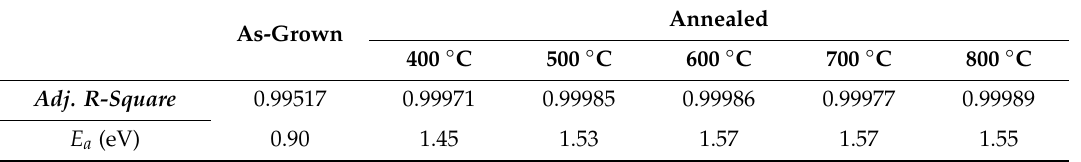
Table 2. The coe ffi cient of determination ( Adj. R-Square ) for the fittings and activation energy ( E a ) for the relaxation processes of the as-grown and annealed Mn:PIMNT single